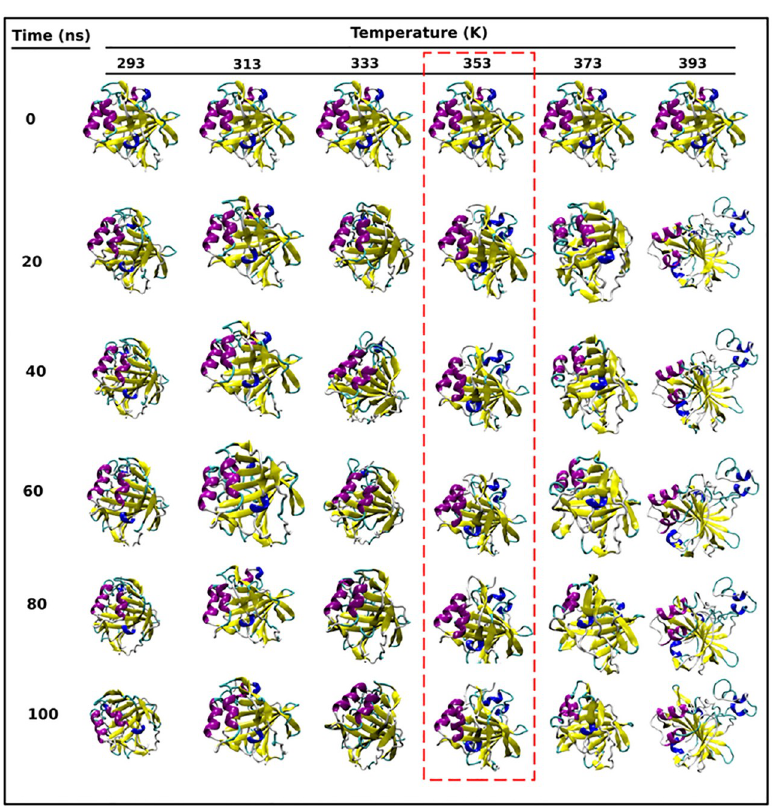
Fig 5. Unfolding pathways of SazCA. The structural snapshots taken at 0, 20, 40, 60, 80 and 100 ns of different configurations of SazCA at 293, 313, 333, 353, 373 and 393 K, describing the unfolding pathways with respect to its native state. α -helices are shown with violet color, 3 10 -helices with blue color, β -sheets with yellow color, loops (turns and coils), are shown in white and cyan color. The native-like structure found at 353 K is represented with red color dashed